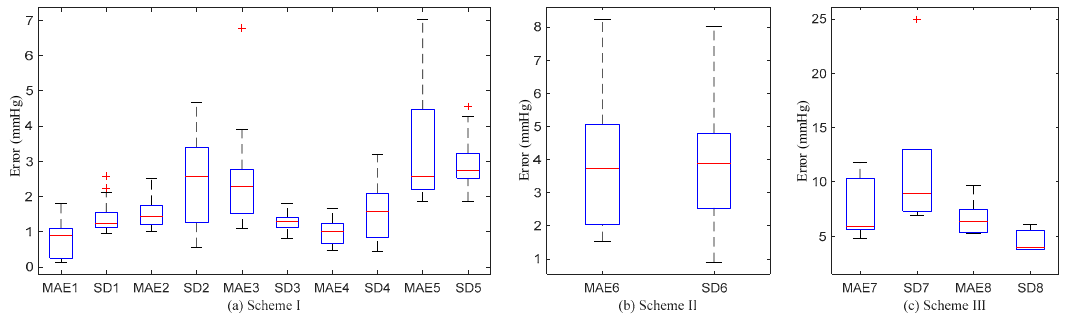
Figure 9. Box plots of the model performance. ( a ) MAE1-MAE5 and SD1-SD5 of scheme I, ( b ) MAE6 and SD6 of scheme II, ( c ) MAE7-MAE9 and SD7-SD9 of scheme III.